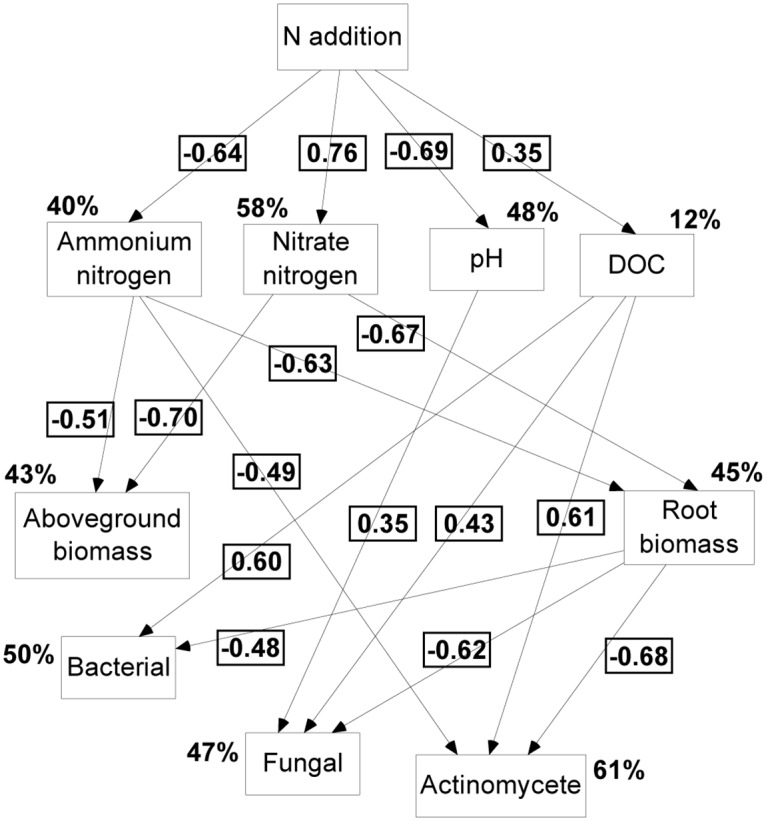
Structural Equation Model (SEM) of N addition effects on bacterial, fungal, and actinomycete.The final model fit the data well: x215 = 8.083, P = 0.201, Akaike Information Criteria (AIC) = 130.000, RMSEA = 0.311. Percentages close to endogenous variables indicate the proportion of variation explained by the model (R2). Numbers at arrows are standardized path coefficients represent the pathways have significant effects (P < 0.05). DOC, dissolved organic carbon.